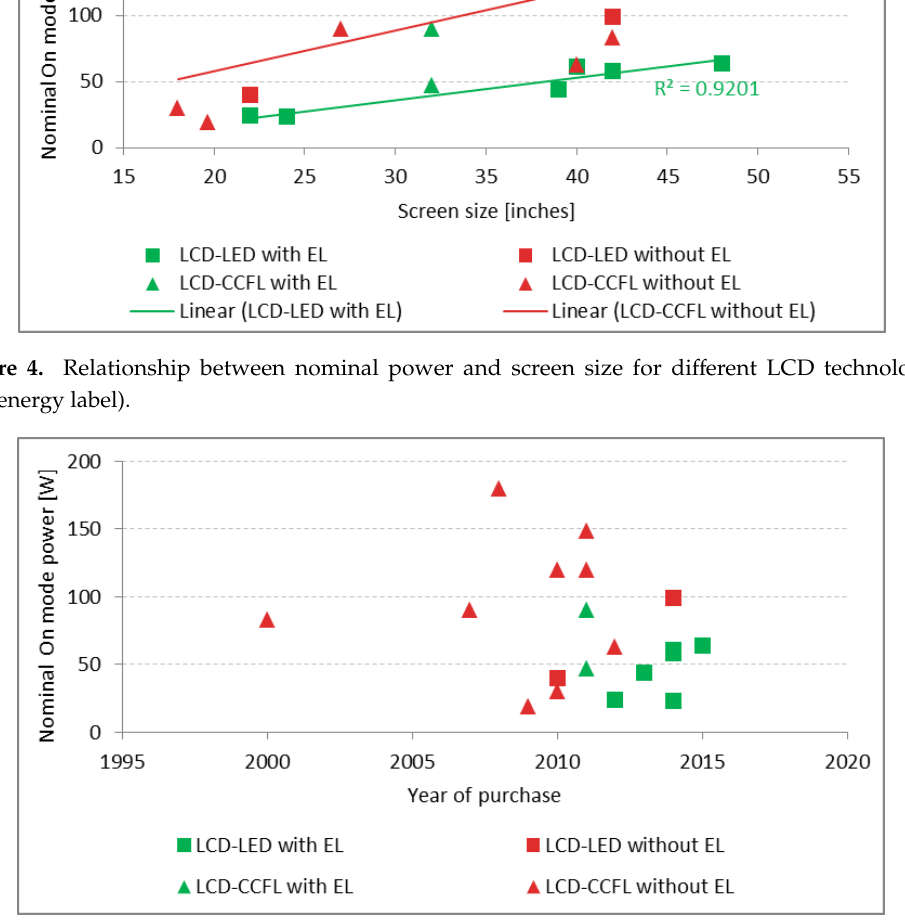
Figure 5. Relationship between nominal power and year of purchase for different LCD technologies (EL: energy label).